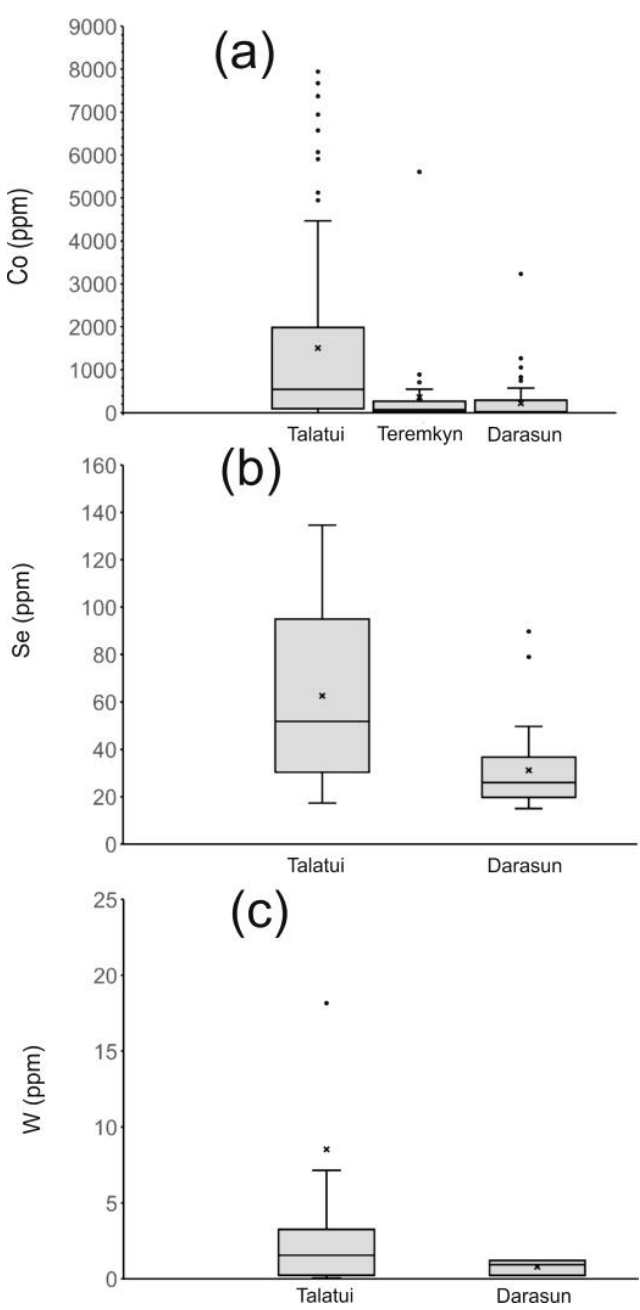
Figure 11. Boxplot diagrams of elements whose concentrations decrease with a temperature de- crease: a —Co, b —Se, c —W.